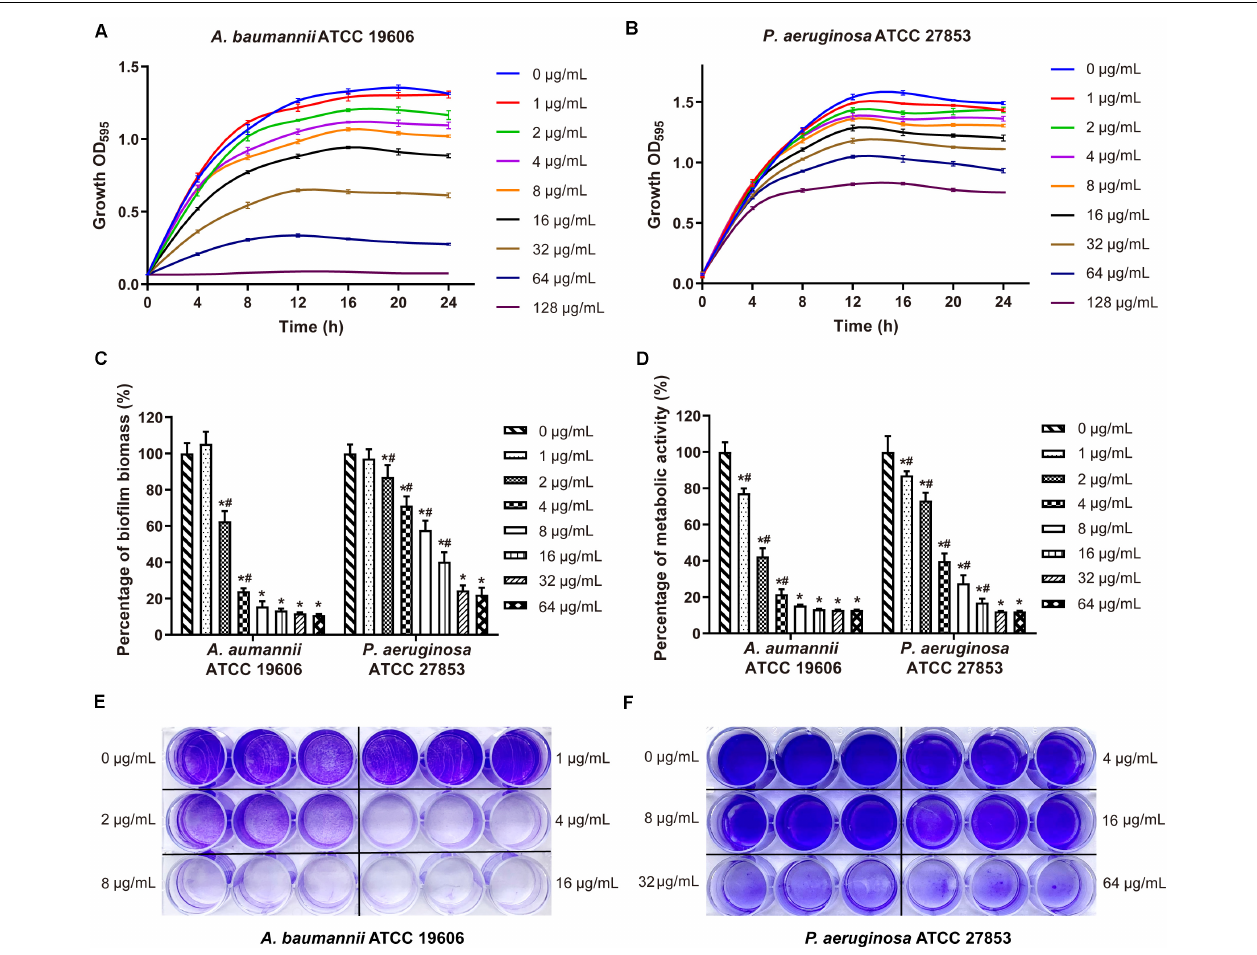
FIGURE 2 | Effects on bacteria growth and biofilm formation by maipomycin A (MaiA). Growth curves of A. baumannii (A) and P. aeruginosa (B) treated with various concentrations of MaiA. Effects of MaiA on biomass (C) and cell metabolic activity (D) in bacterial biofilms. CV stain assay of MaiA on A. baumannii (E) and P. aeruginosa (F) biofilm biomass formation in the 24-well flat bottom plate. *Indicates P < 0.05 compared with untreated controls. # Indicates P < 0.05 compared with the previous